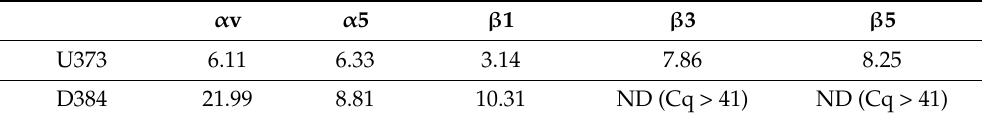
Subsequently, the active compound NDI-1 was tested on U373 cells at different concen- trations (0.1, 1, 10, and 20 µ M) and time of contact (24 and 48 h) to identify the minimum effective concentration and time. A concentration of 1 µ M induced a marked decrease in cell viability after 24 h of contact (Figure